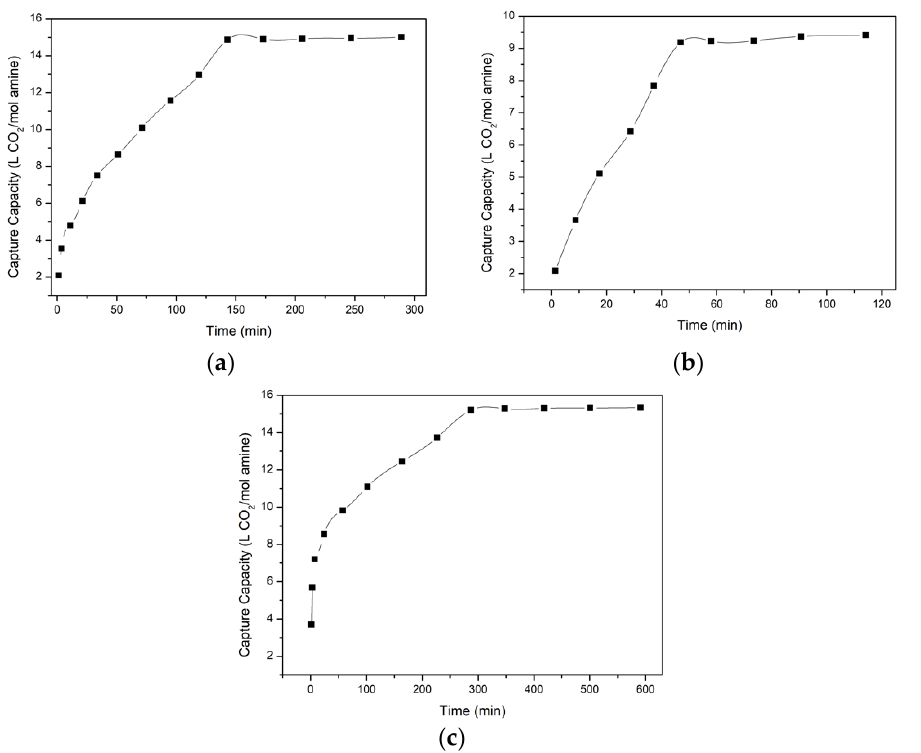
Figure 4. The saturated CO 2 adsorption capacities of ( a ) 3-Amino-1-propanol, ( b ) ethylamine, and ( c ) diethylenetriamine.